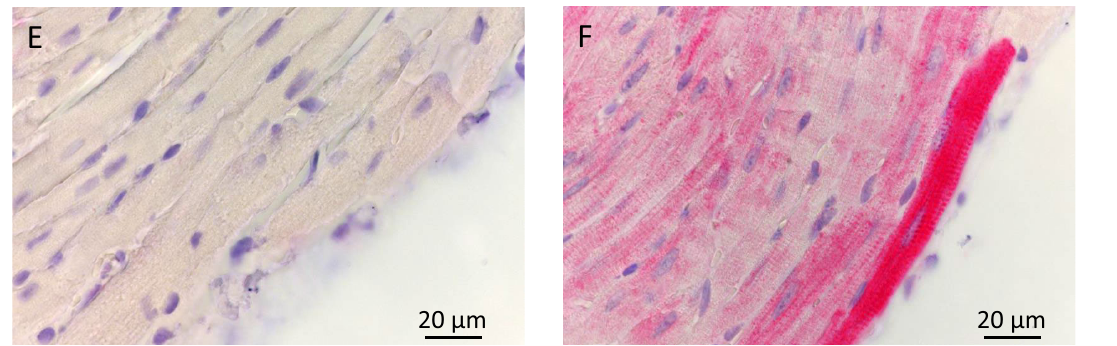
Figure 2. Immunohistochemical visualization of piezo2 in cardiac tissues. ( A ) Isotype control and ( B ) piezo2- staining of rat EHT. ( C ) Isotype control and ( D ) piezo2 staining of a rat papillary muscle. Note that endothelial cells and smooth muscle cells were also positive for piezo2. ( E ) Ventricular tissue of a Piezo2-KO and ( F ) a wildtype mouse stained for piezo2. Nuclei were counterstained with hematoxylin (blue) in all